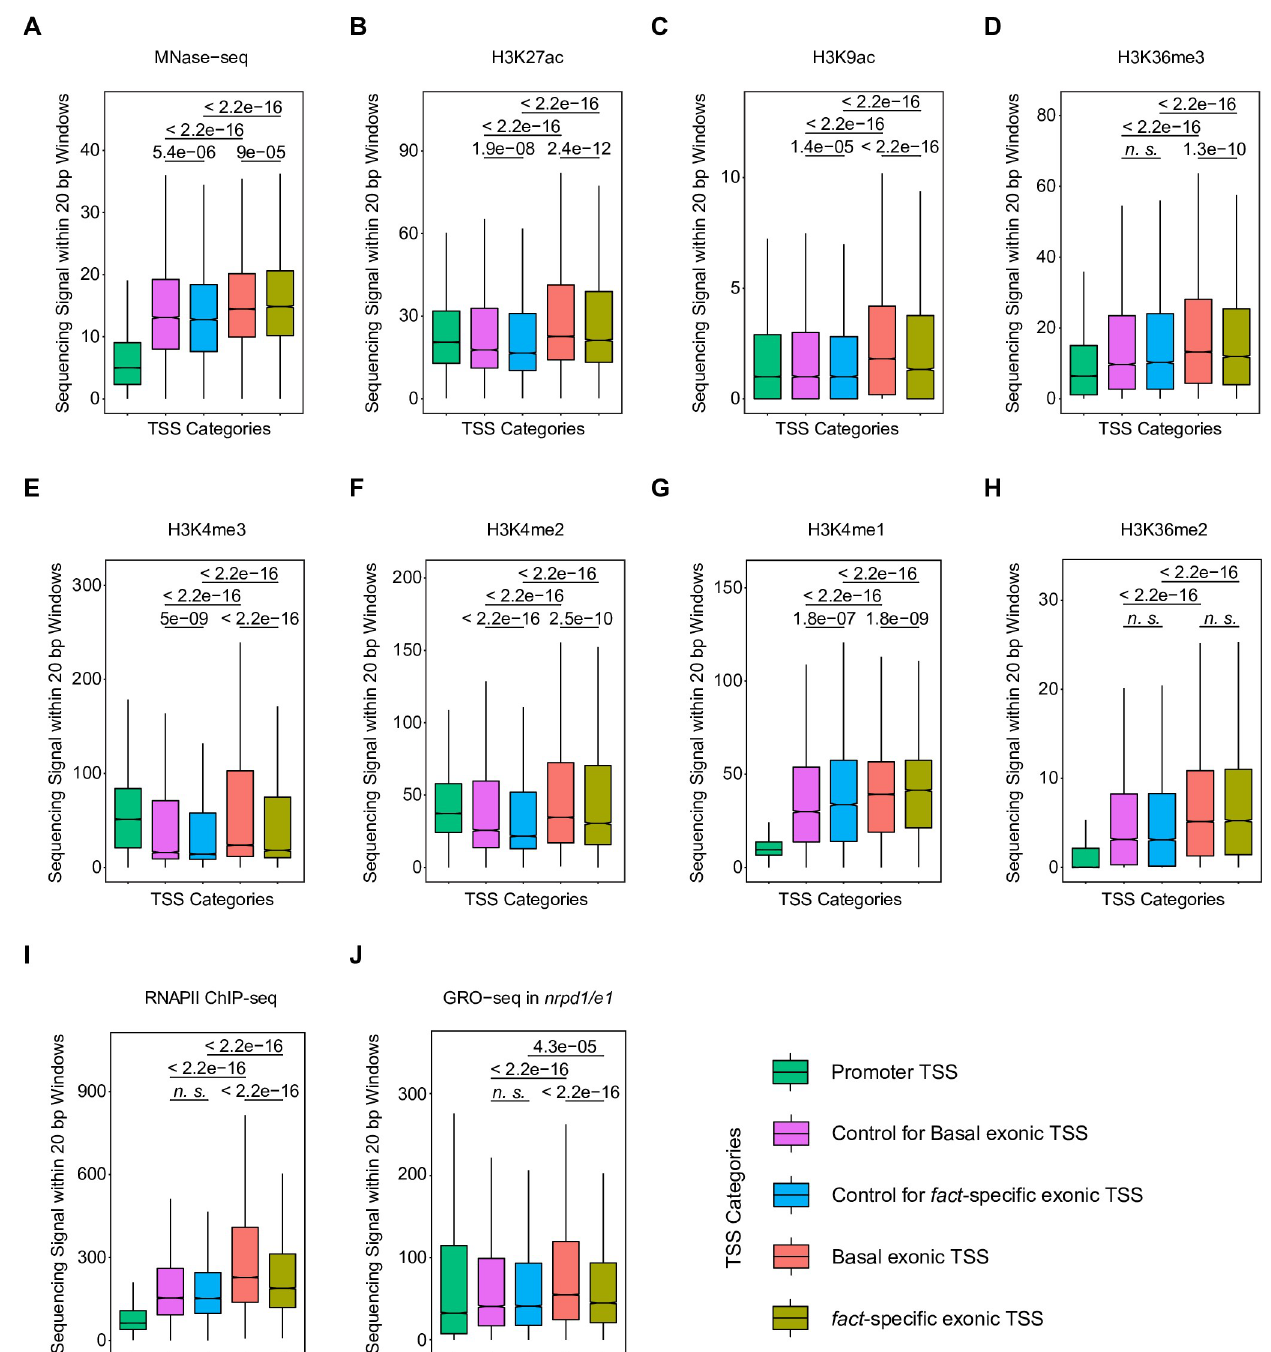
Fig 6. H3K4me1 is enriched at FACT-repressed TSS positions. Boxplots show the distribution of median ChIP-seq, GRO-seq and MNase-seq signals within 20 bp windows centered at the following positions: i) Promoter TSS (green); ii) Control exonic positions in genes with basal exonic TSS (purple); iii) Control exonic position in genes with fact -specific TSS (blue); iv) Basal exonic TSS (salmon); v) fact -specific exonic TSS (olive). The notch denotes the median value, hinges denote quartiles and whiskers show the spread of non-outlier values (found within 1.5 � IQR from the respective quartile). The p-values were calculated by Wilcoxon test. The following datasets were included: (A) MNase-seq; (B) H3K27ac; (C, D) H3K9ac and H3K36me3; (E, F, G) H3K4me3, H3K4me2 and H3K4me1; (H) H3K36me2; (I) RNAPII ChIP-seq; (J) GRO-seq.